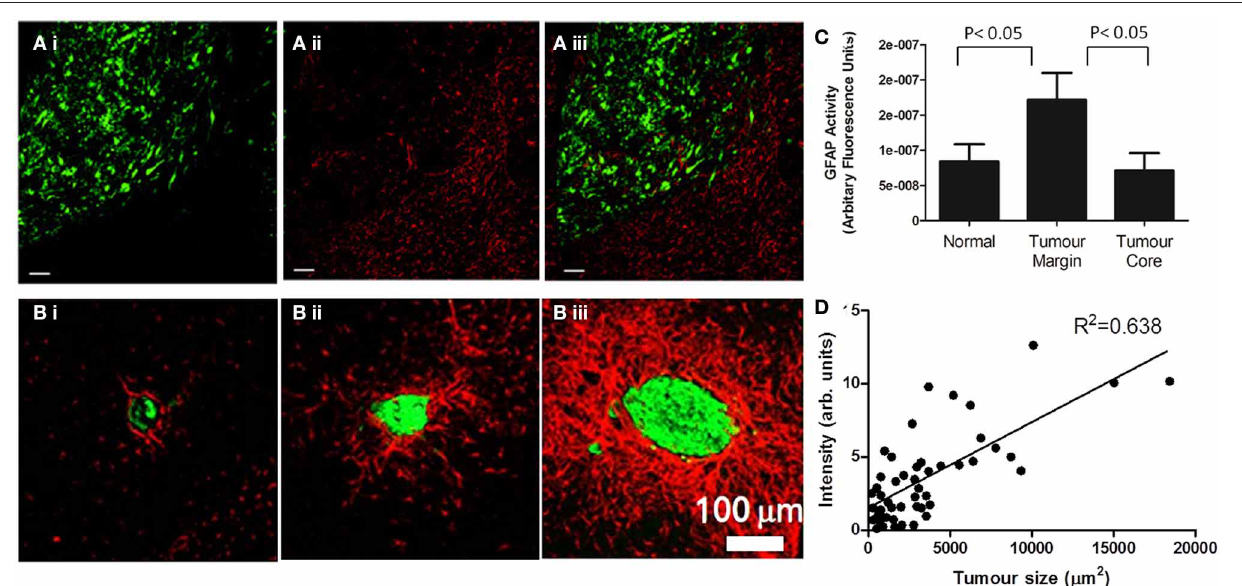
FIGURE 1 | Astrocyte activation, as determined by GFAP staining, is present in the peri-tumoral area of both primary (A) and secondary (B) tumors. (A) (i) In a mouse model of glioma, the growth of DBRTG glioma cells can be seen in green (GFP labeled), adjacent to a wall of astrocyte activation, seen in red (Alexa555 probe) (ii). The merged image (iii) indicates little infiltration of activated astrocytes into the tumor mass, as quantified by arbitrary fluorescence units of GFAP activity (C) . Figure